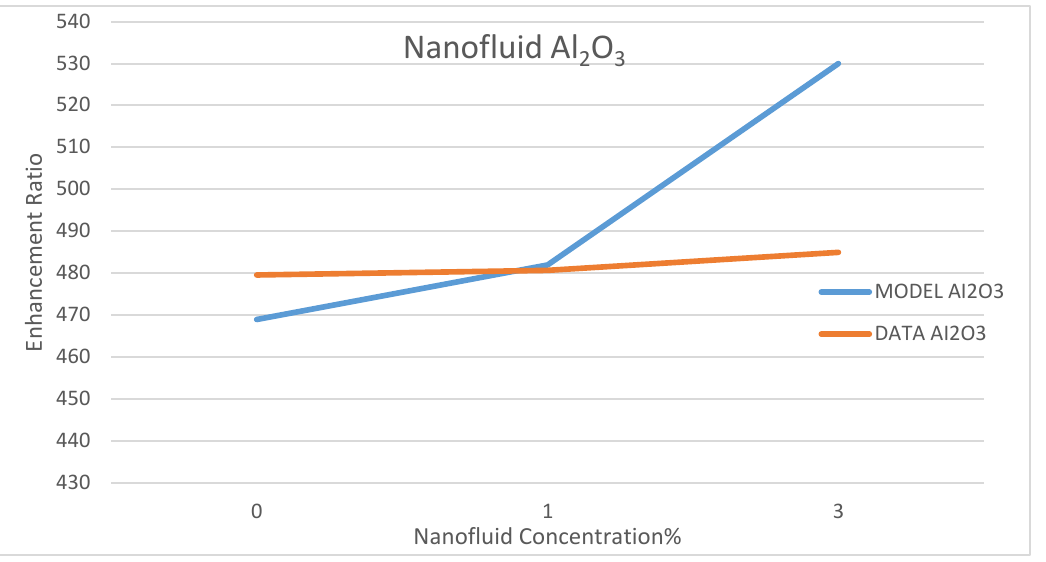
Figure 33. Comparison between model and data of Bellos and Tzivanidis [35] as in text is (Al 2 O 3 ) and applies to all other Figures.